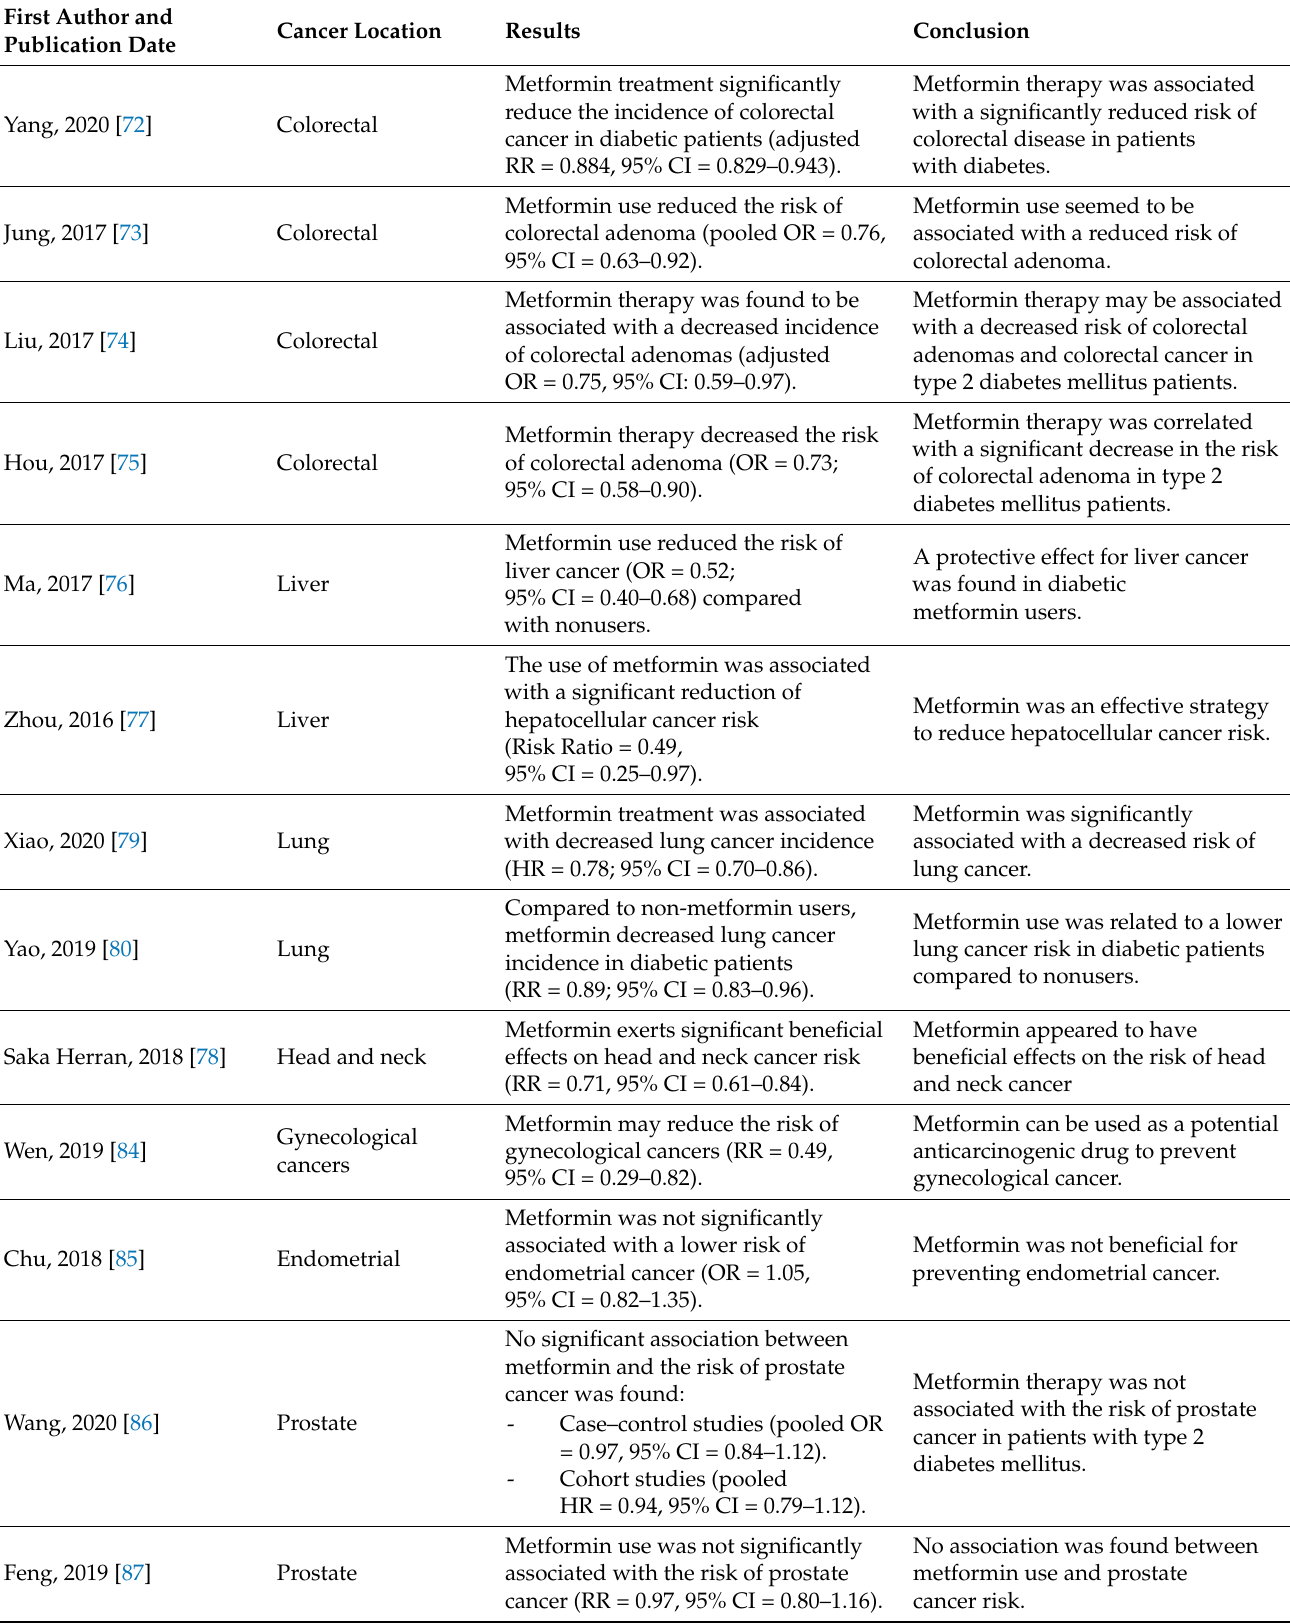
Table 2. Meta-analyses of the effect of metformin on the risk of cancer in the last 5